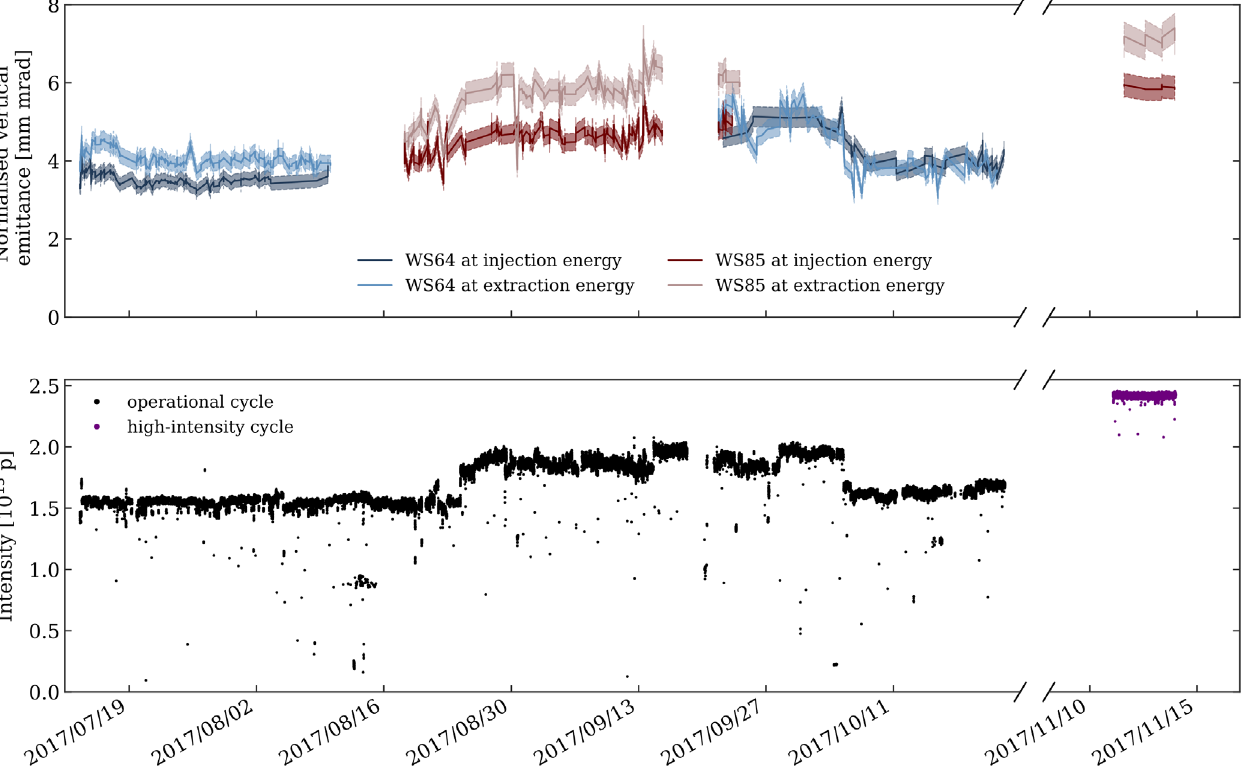
FIG. 7. Evolution of the vertical beam emittance measured at PS injection (190 ms) and just before transverse splitting (700 ms) for the two wire scanners (upper). The coloured bands around the measured emittance values indicate the error bars, which account for the goodness of the Gaussian fit and the beta-beating at the WS locations. The lower plot shows the circulating beam intensity before extraction over time. Data is shown for the operational period (until end of October 2017) and for the high-intensity tests in November 2017. The different steps in intensity for the operational beam indicate different requirements for the fixed-target physics